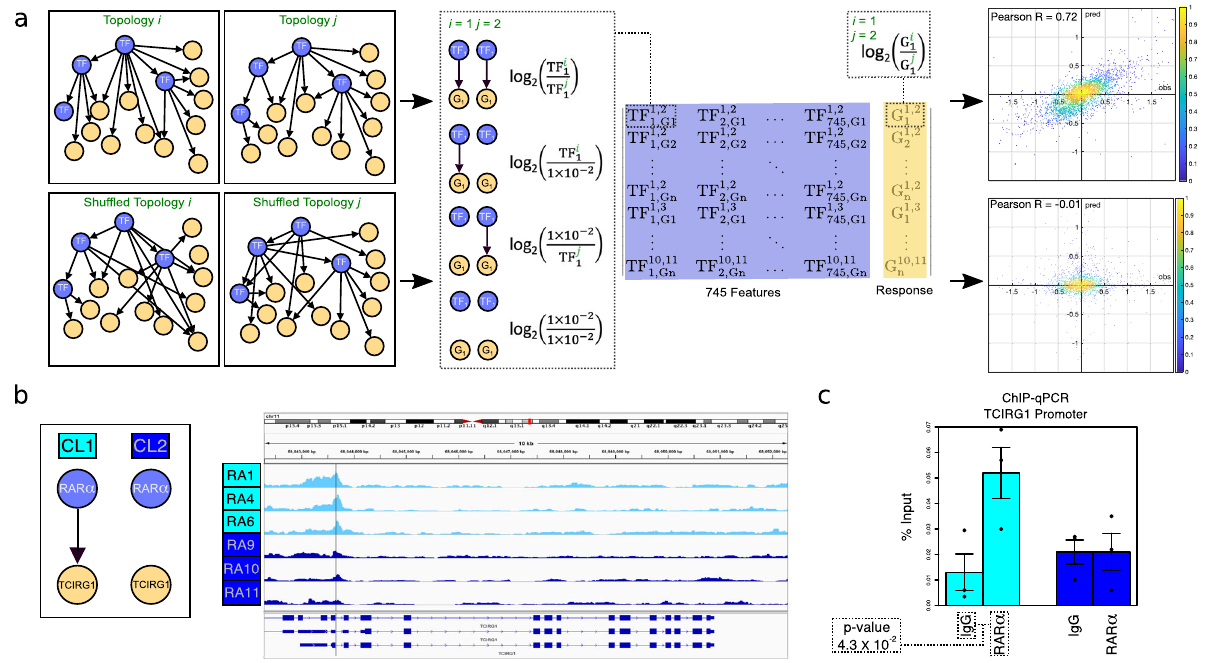
Fig. 2 | Computational and experimental veri fi cation of personalized tran- scriptional gene regulation networks for Rheumatoid Arthritis Fibroblast-like Synoviocytes. a Computational validation of predicted regulatory interactions using a 10-fold cross validated Random Forest regression model. b Selected dif- ferentialedgeformedbyrank1cluster-speci fi cTF,RAR α → TCIRG1.ATAC-seqtrack from top 3 (CL1) and bottom 3 (CL2) patients as ranked by RAR α PPR, showing TCIRG1 gene and location of ATAC-seq peak centered on RAR α motif at ( p -value =7.19× 10 − 5 from a hypergeometric test for over-representa- tion). In contrast, the CL2 TFs are involved in “ SMAD2/SMAD3:SMAD4